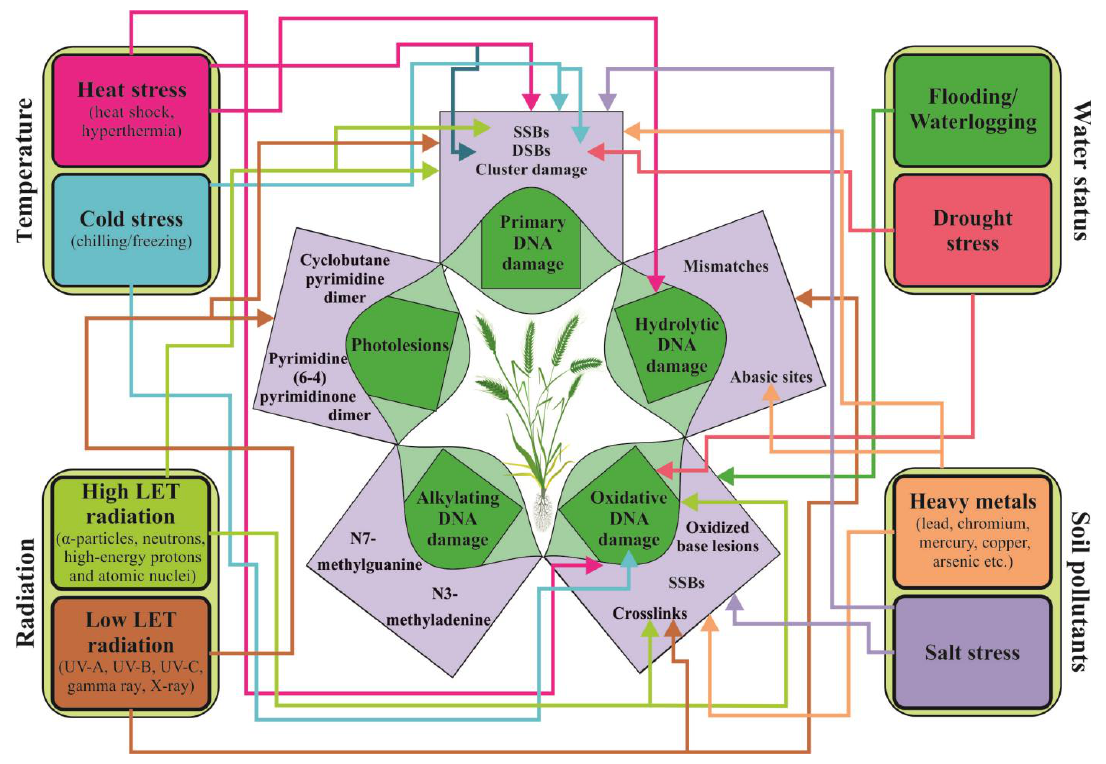
Figure 2. Overview of the main types of DNA lesions observed in plant genomes in response to abiotic stress. Radiation as a stressor can lead to the accumulation of various types of DNA damage in plant cells, including direct DNA damage (SSBs, DSBs, and cluster damage), photolesions (6-4 photoproducts and cyclobutane-pyrimidine dimers), base damage, and interstrand crosslinks, depending on the radiation properties (high or low LET). Temperature, water, and salt stress can cause direct DNA lesions and oxidative damage due to an overproduction of ROS. Heat stress can also lead to hydrolytic lesions, similar to those caused by heavy metal stress. Primary alkylated damage is not connected to the stress factors shown in the figure as it results from the application of alkylating agents, which are not typical stress factors for plants. The relationships between specific DNA lesions and stress factors are indicated by arrows.